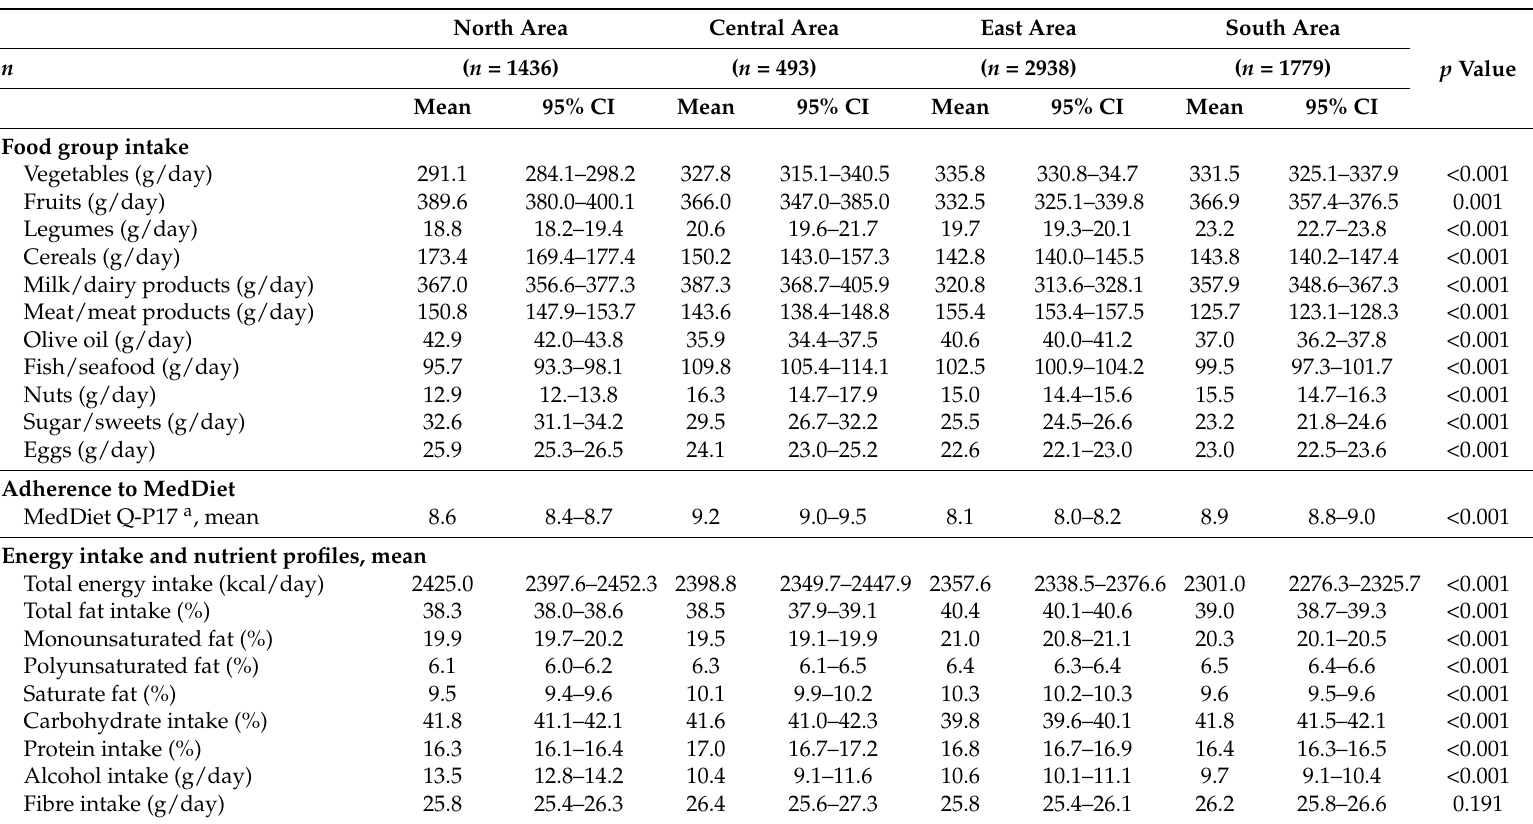
Table 2. Intake of food groups (g/day), adherence to MedDiet and nutrient profiles among geographical areas analysed (total population n =